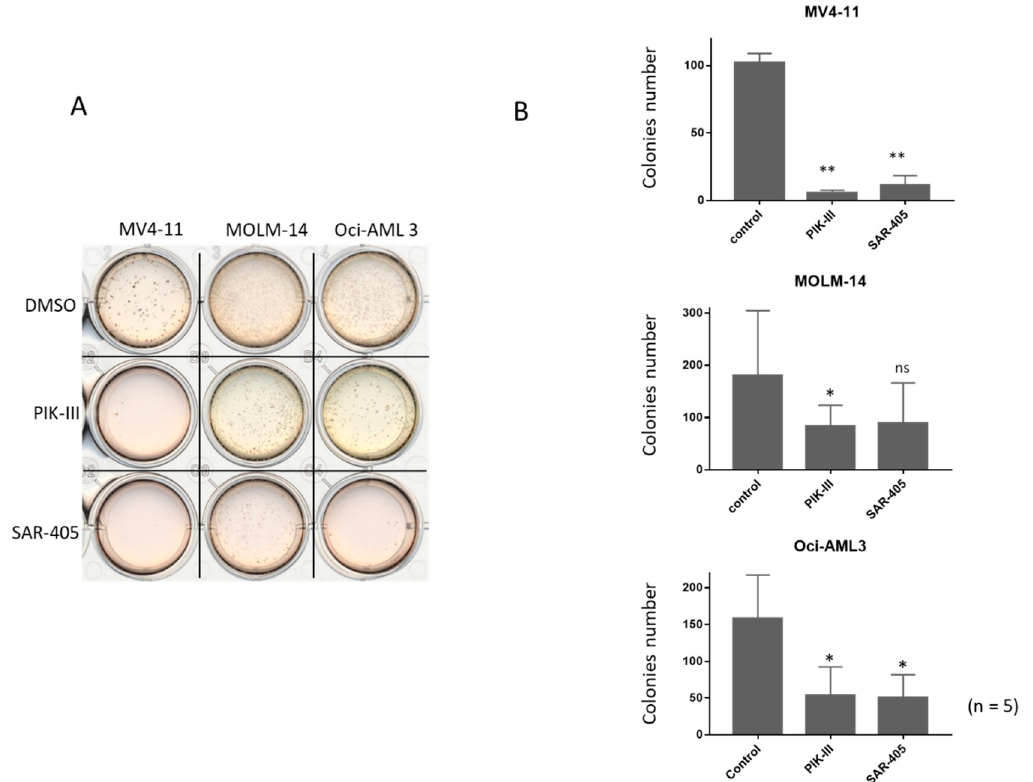
Figure 3. Inhibition of autophagy reduces repopulating capacity and colony number of FLT3-ITD AML cells. AML cells were incubated for 7 days at 1% O 2 and then treated or not for 7 more days at 20% O 2 . After cell counting at d14, 10 3 cells were seeded in methylcellulose and incubated at 37 °C at 20% O 2 . After 14 days in methyl cellulose, colony number was quantified. ( A ) A representative observation of colonies in methylcellulose. ( B ) Results from at 5 experiments are shown. Significance was quantitated using Wilcoxon test and is shown by an asterisk (ns: not significant, * p < 0.05, ** p < 0.01).